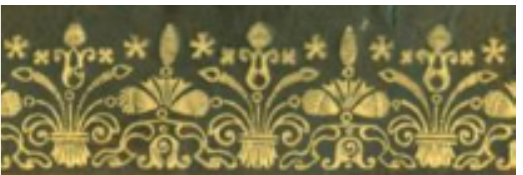
Fig. 44b. Enlargement of gold tooled roll used in the frame. BL, C.190.e.12.